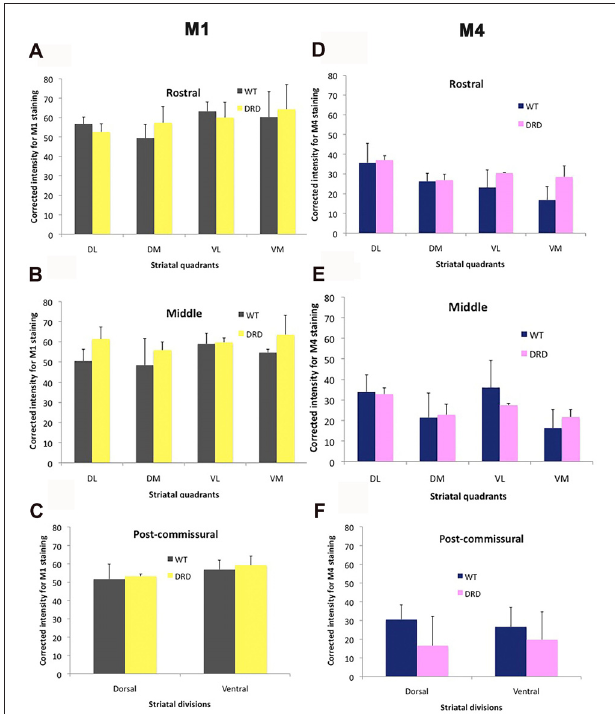
FIGURE 8 | (A–F) Comparisons of M1 and M4 immunostaining intensity (Average ± SEM) in the different striatal regions depicted in Figure 1 between WT and DRD mice. No significant difference in staining intensity for either receptor subtype was found between the two animal